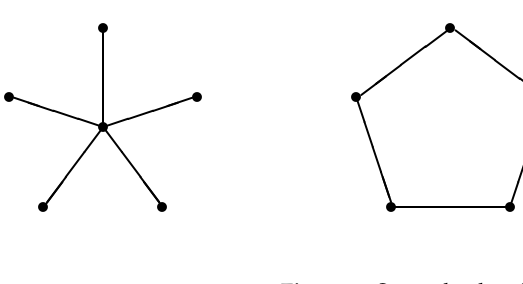
Figure 1. Star, wheel and complete